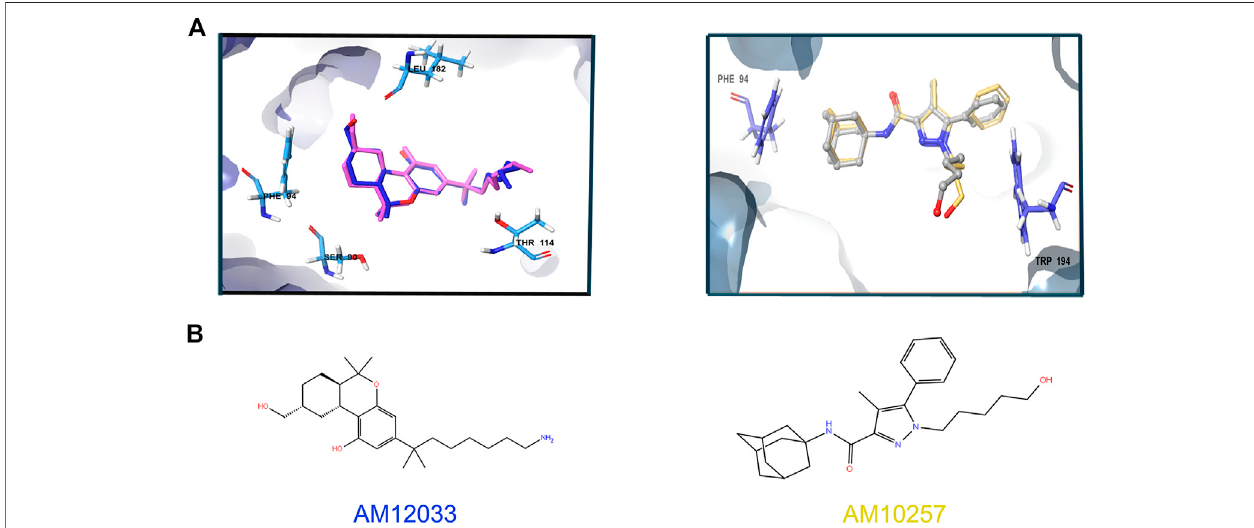
FIGURE 3 | Superimposition of the redocked ligands at 6KPC and 5ZTY. (A) Left: relevant residues at 6KPC are shown in azure sticks (SER90, PHE94, LEU182, THR114andLEU182).Theredockedagonist(AM12033,dockingscore= − 12.2 kcal/mol) — bluealignedwiththeoriginalligand(pink),withRMSD=0.94.Right:relevant residues(PHE94and TRP194)at 5ZTYareshown inbluesticks.Theredockedantagonist(AM10257, docking score= − 10.8 kcal/mol) — yellow alignedwiththeoriginal ligand (gray), with RMSD = 1.5. (B) 2D representation of the agonist and antagonist ligands.